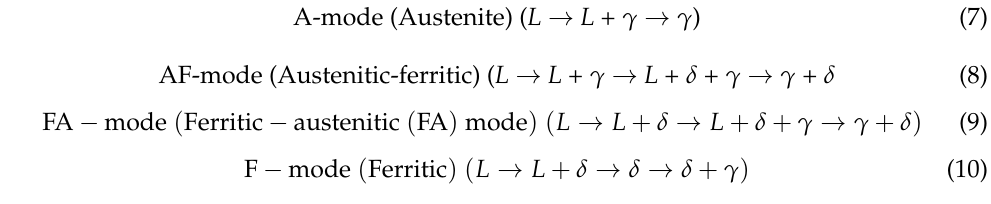
Figure 4. Fe-Ni-Cr Pseudo binary phase diagram.